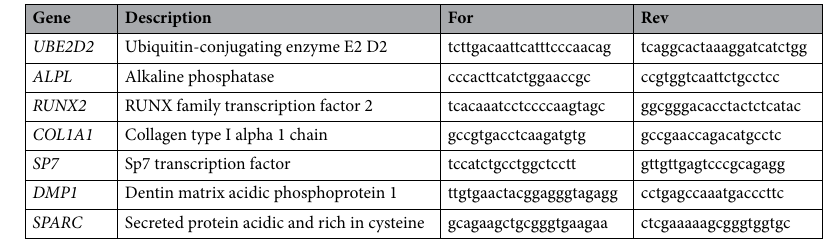
Table 2. Sequences of primers used for real-time